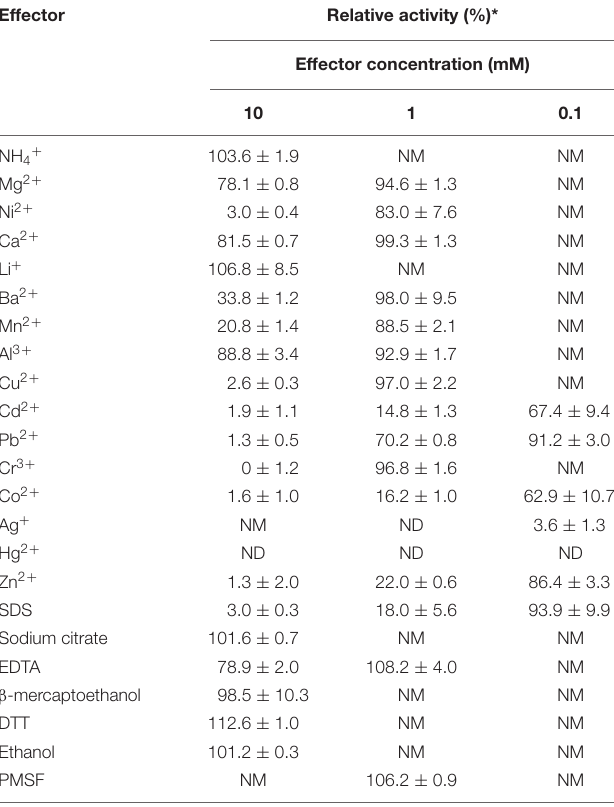
TABLE 1 | Effect of various effectors of the xylanolytic activity of XynDZ5. Effector Relative activity